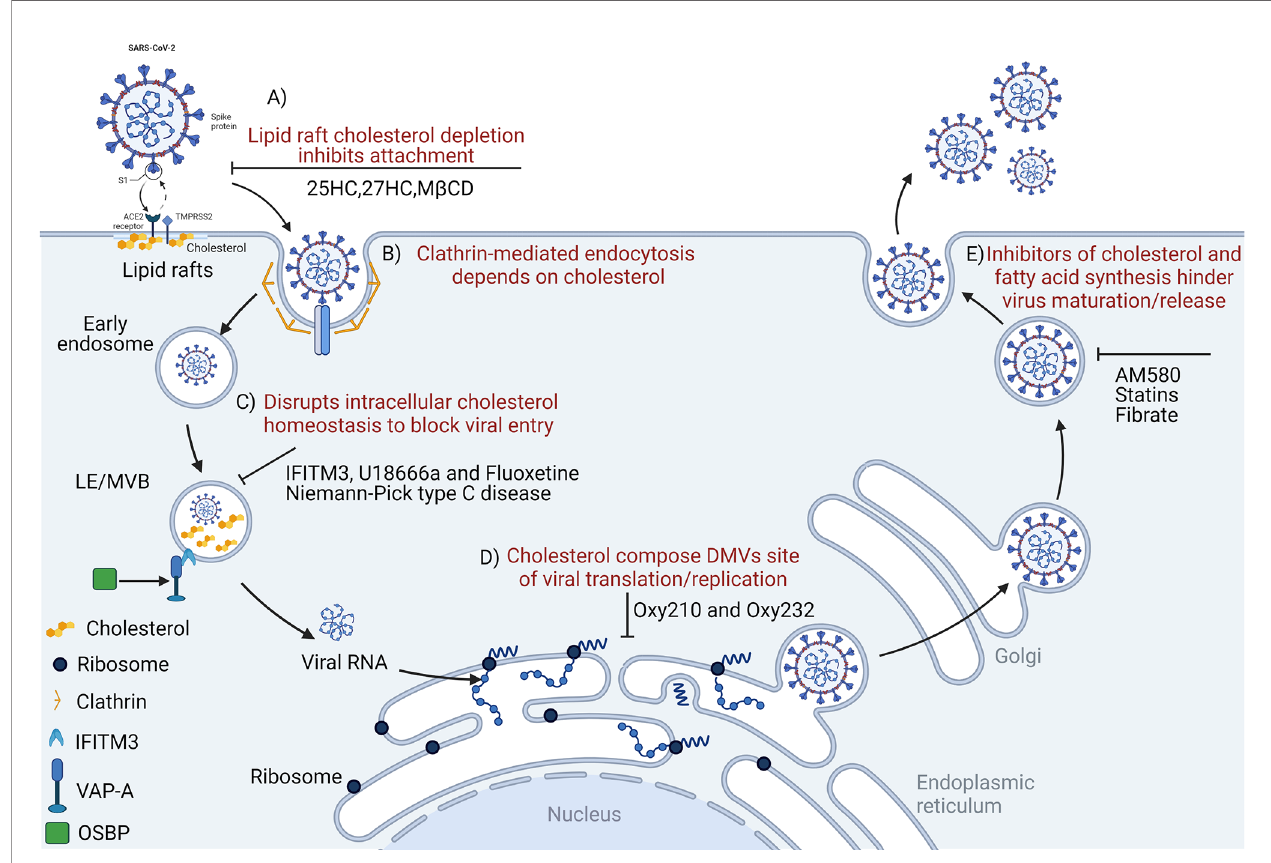
FIGURE 1 | Disrupting cholesterol homeostasis interferes with critical steps during coronavirus infection. Cholesterol is important for coronavirus attachment (A) , endocytosis (B) , membrane fusion (C) , translation/replication (D) , and maturation/release (E) . 25HC, 25-hydroxycholesterol; M b CD, methyl-beta-cyclodextrin; LE/MVB, late Endosomes/Multivesicular Bodies; IFITM3, interferon-induced transmembrane protein-3; U18666a, an intra-cellular cholesterol transport inhibitor; DMVs, double-membrane vesicles; OSBP, oxysterol-binding protein; VAP-A, vesicle-membrane-protein-associated protein A; Oxy210, semi-synthetic oxysterols; Oxy232, semi-synthetic oxysterols; AM580, a selective retinoic acid receptor- a